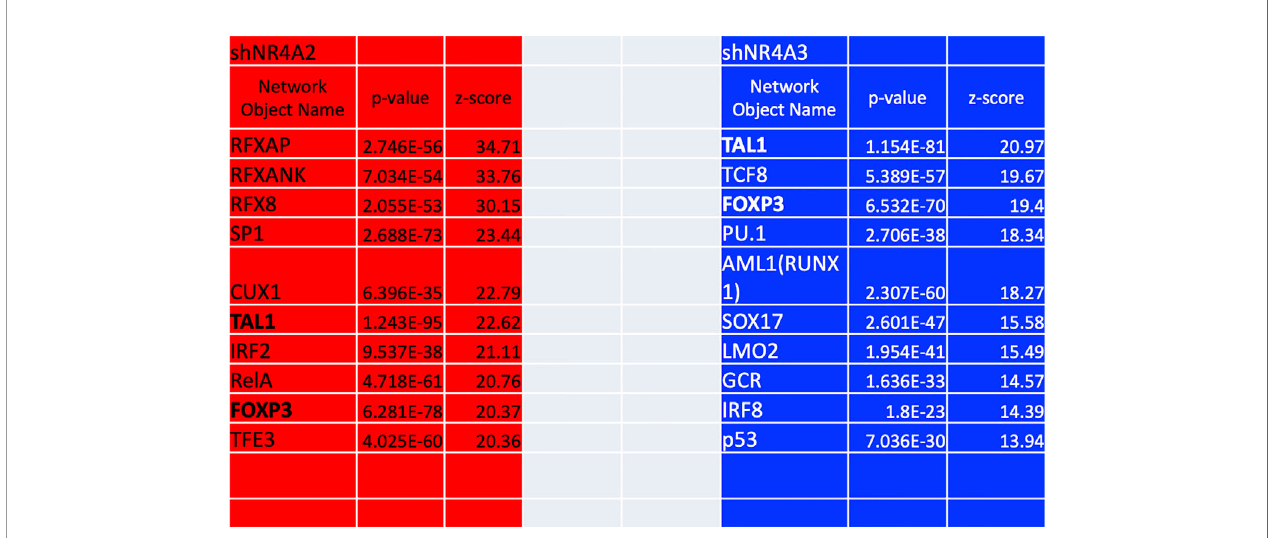
FIGURE 9 | Transcription factor enrichment analysis of genes in NR4A2 and NR4A3 depleted cells. Table depicting the top 10 results ranked by z-score from Metacore transcription factor enrichment analysis performed on NR4A2 (red) and NR4A3 (blue) depleted cells. Network object name refers to the enriched transcription factor network, p-value refers to the statistical signi fi cance of the observation and z-score refers to the distance from the expected